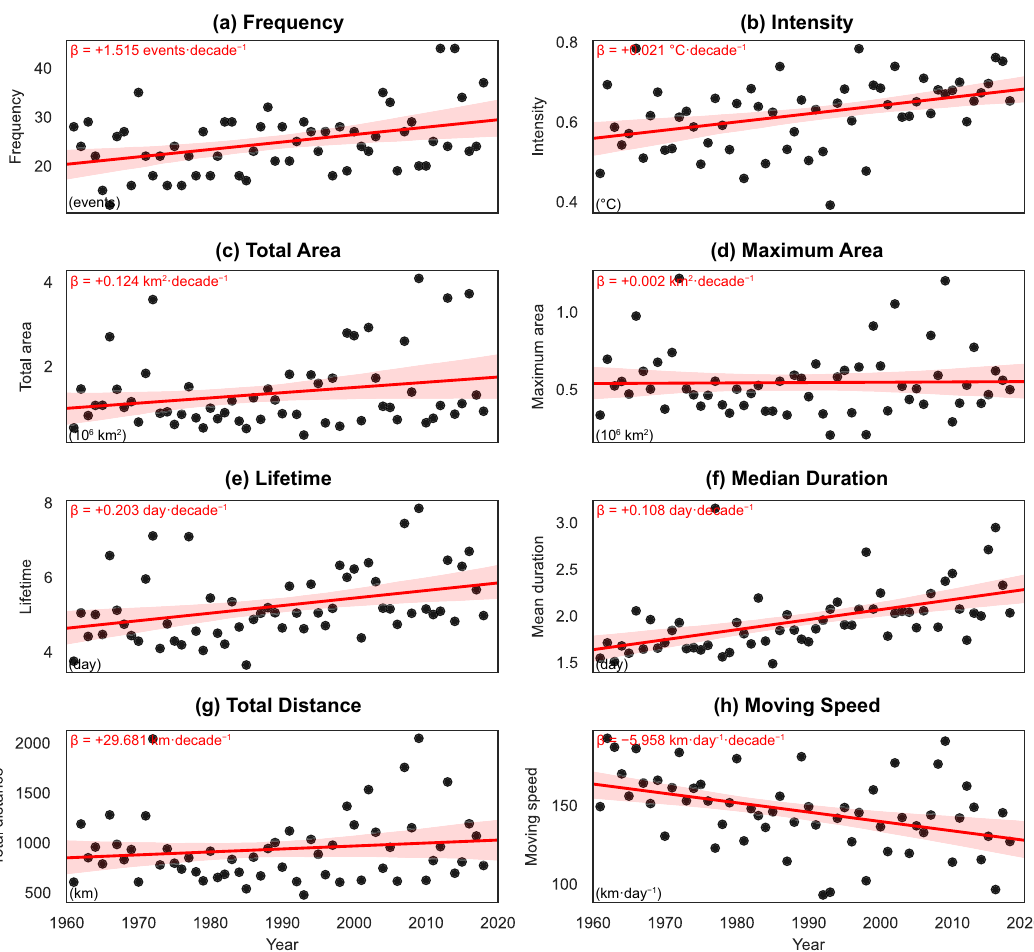
Fig. 4 Time series of the yearly statistics of Type 1 contiguous heatwaves during 1961 – 2018. a Time series of the yearly frequency of the contiguous heatwave. b – h As ( a ) but for intensity, total area, maximum area, lifetime, median duration, total moving distance, and moving speed, respectively. The red straight line indicates the corresponding linear trend, with the red text indicating the trend magnitude. The pink shading indicates the 95% con fi dence interval of the fi tted line. All trends are statistically signi fi cant at the 0.05 level except for moving